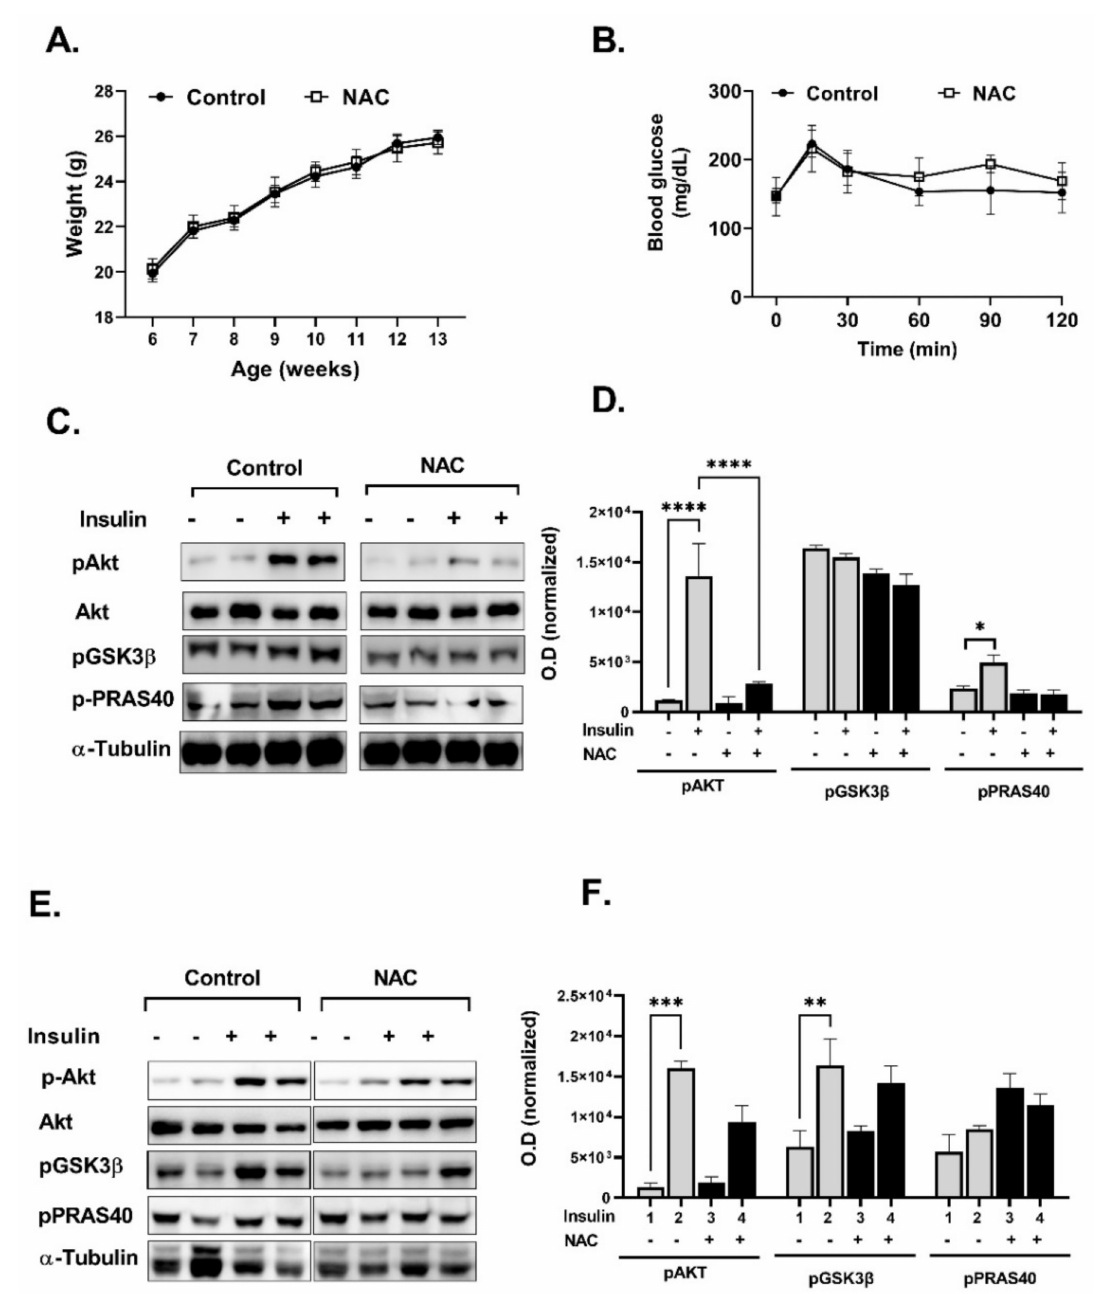
Figure 9. NAC attenuated insulin signaling in normoglycemic mice. C57BL/6 mice ( n = 8, 6 weeks old) were given NAC (1200 mg/kg/day) for 6 weeks, as described in Methods. ( A ) Body weight was measured every week. ( B ) Glucose tolerance test (GTT) was performed at age of 12 weeks as described in Methods. Western blot analysis and densitometry analysis of proteins involved in insulin signaling pathway was performed in muscle ( C , D ) and liver ( E , F ). Optical density was normalized to the non-phosphorylated form or to housekeeping protein. The results are presented as the mean ± SEM. * p < 0.05, ** p < 0.005, *** p < 0.0005 and **** p < 0.0001 by one-way Anova ( A ) followed by Bonferroni’s post hoc